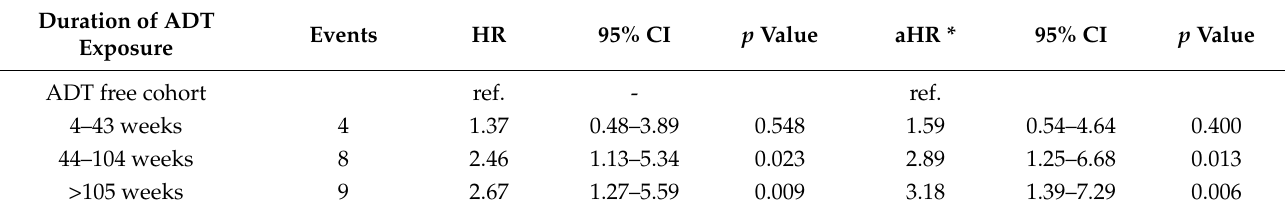
Table 3. Hazard ratios (HR) for RA in men with prostate cancer on GnRH agonists according to cumulative duration of